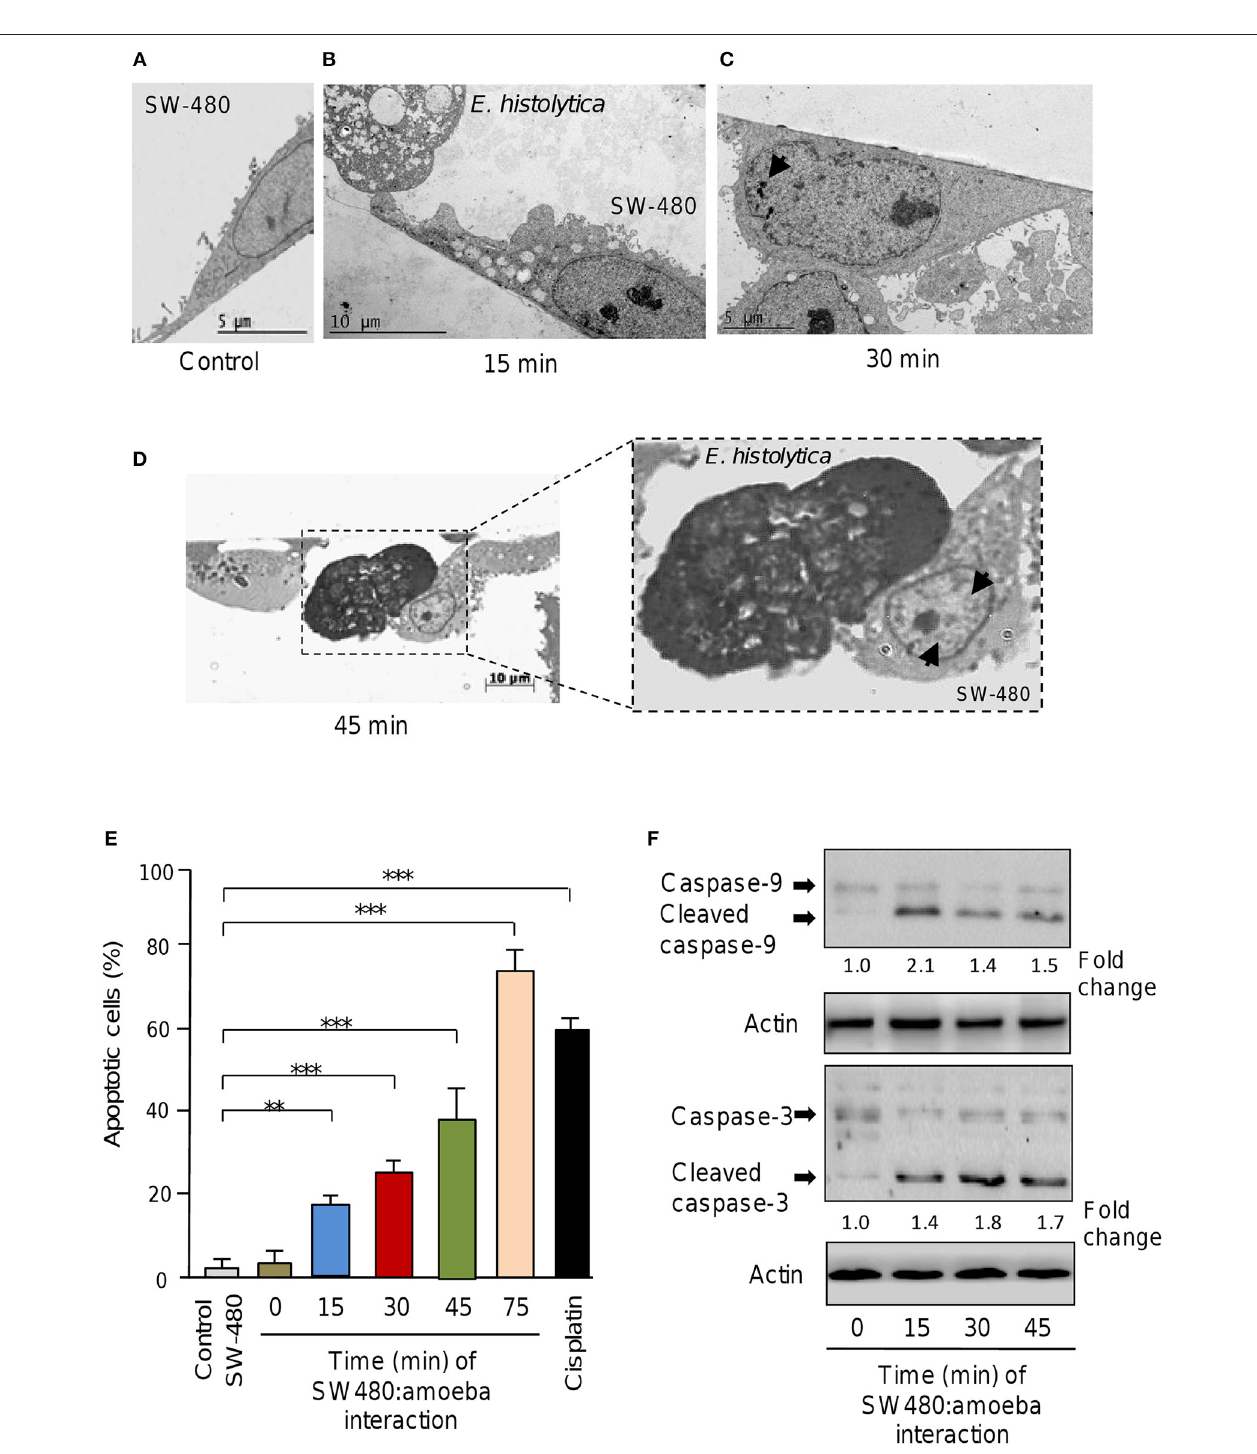
FIGURE 1 | E. histolytica induces apoptosis in SW-480 cells. (A) Representative transmission electron microscopy ultrastructure image of confluent SW-480 cells showing a well-spread cell with irregular microvilli, mitochondria distributed through the cytoplasm and enlarged nuclei. Scale bar 5 µ M. (B) Image shows transmission electron microscopy ultrastructure images of trophozoites in contact with colon cells after 15, (C) 30 and (D) 45min of co-culture. (D) SW-480 cells showing typical early changes associated with apoptosis including a general cell-shrinkage, loss of microvilli and nuclear chromatin condensation denoted by arrows (close up in D ). Scale bar 10 µ M. (E) Apoptosis assays. SW-480 cells after interaction with E. histolytica trophozoites for 0, 15, 30, 45, and 75min were analyzed by flow cytometry using annexin V. SW-480 cells without exposure to trophozoites and cells treated with cisplatin (50 µ M) for 24h were used as controls. Data are representative